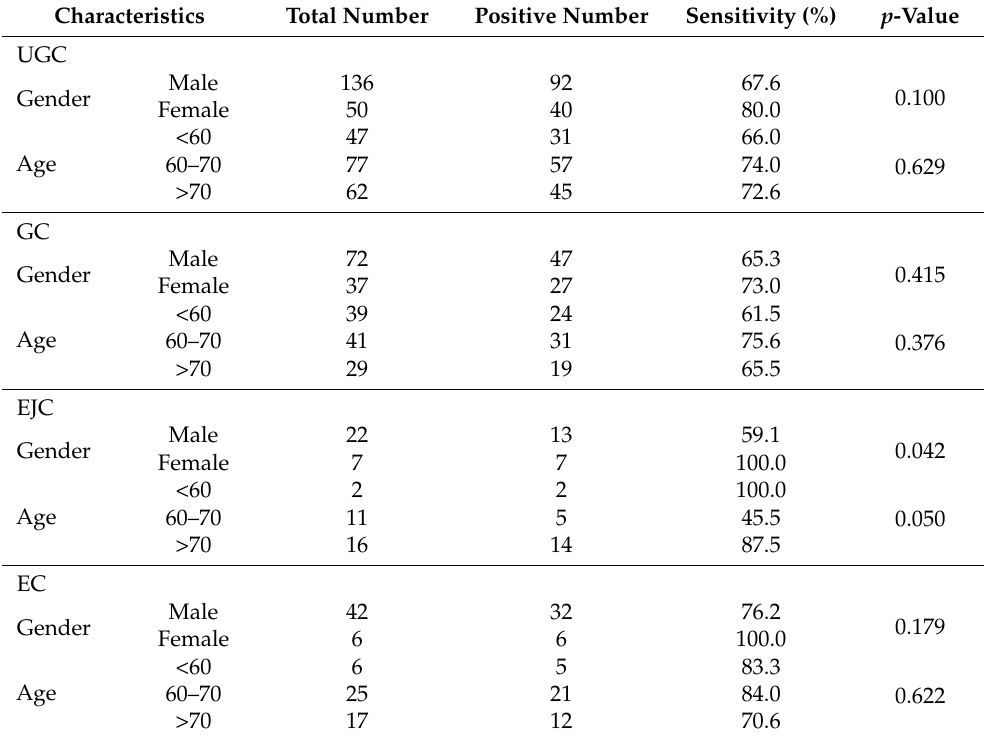
Table 2. Sensitivities of methylation panel in different